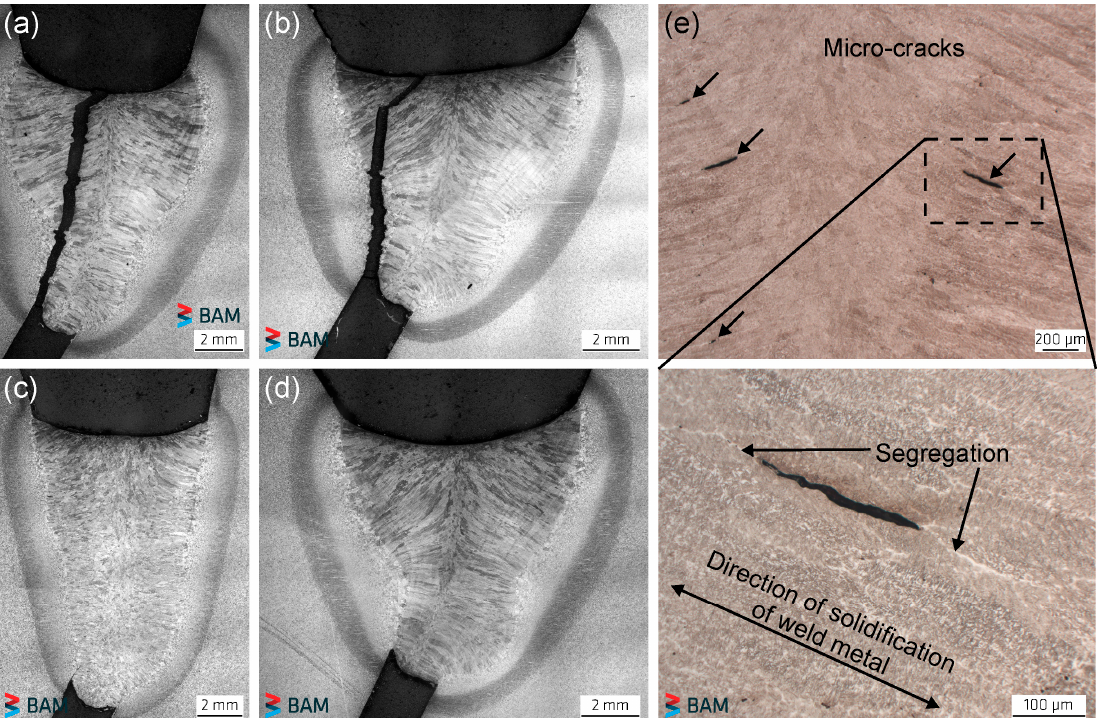
Figure 8. Exemplary micrographs of the cross sections from the TEKKEN samples: ( a ) α = 30°, welded with metal cored wire; ( b ) α = 60°, welded with metal cored wire; ( c ) α = 30°, welded with solid wire with subsequent DHT; ( d ) α = 60°, welded with solid wire with subsequent DHT; ( e ) micro-cracks in weld metal.